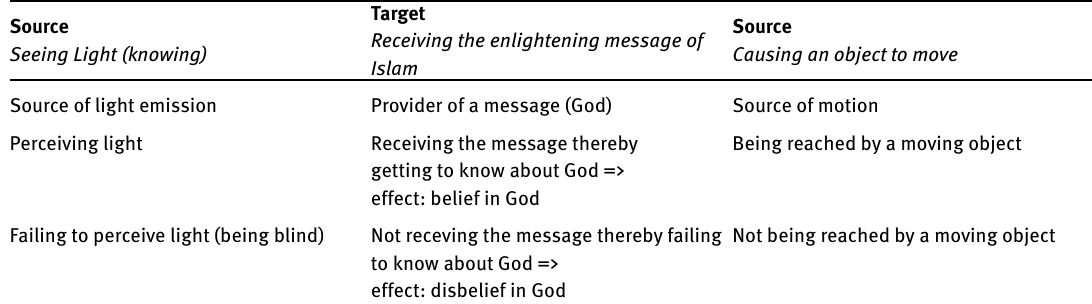
Table 1. Double-source metaphoric amalgam in verse